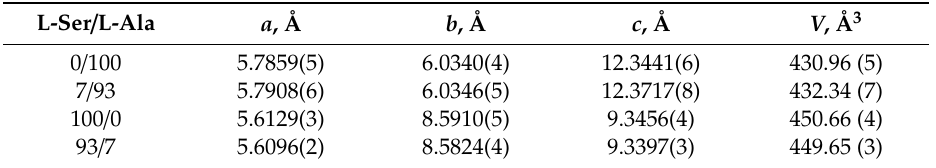
Table 1. Parameters and volume of the orthorhombic cell for L-ser, L-ala, and their solid solutions with L-ser / L-ala ratios of 7 / 93 and 93 / 7.